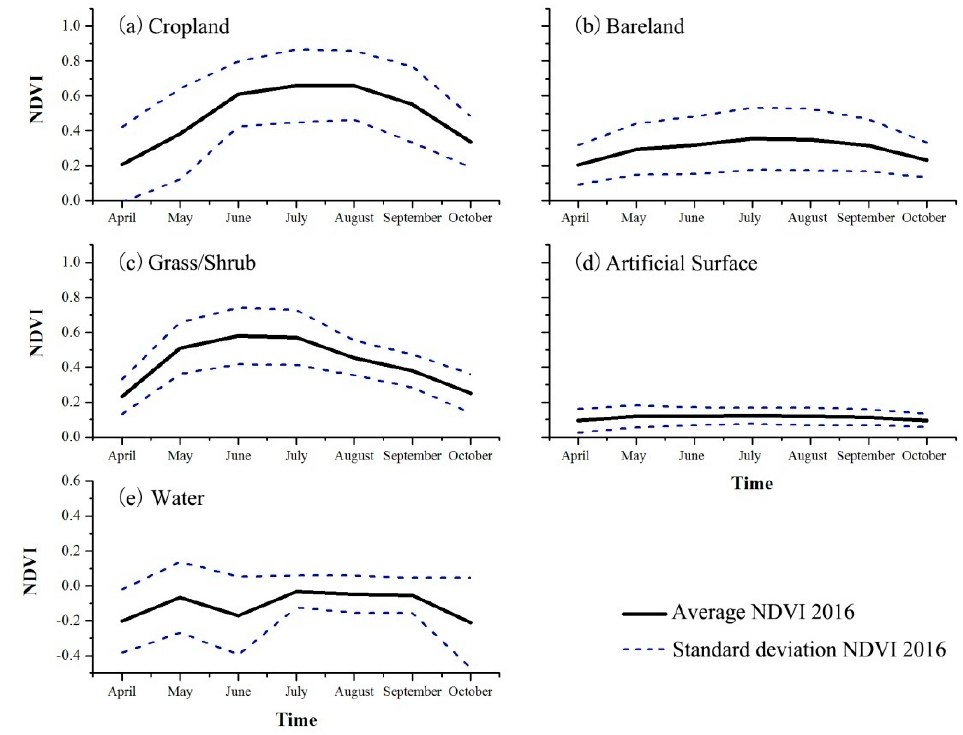
Figure 5. Average and standard deviation of NDVI time series for each class in 2016. Note: NDVI time series of training samples of all seven study sites were used to generate this figure.